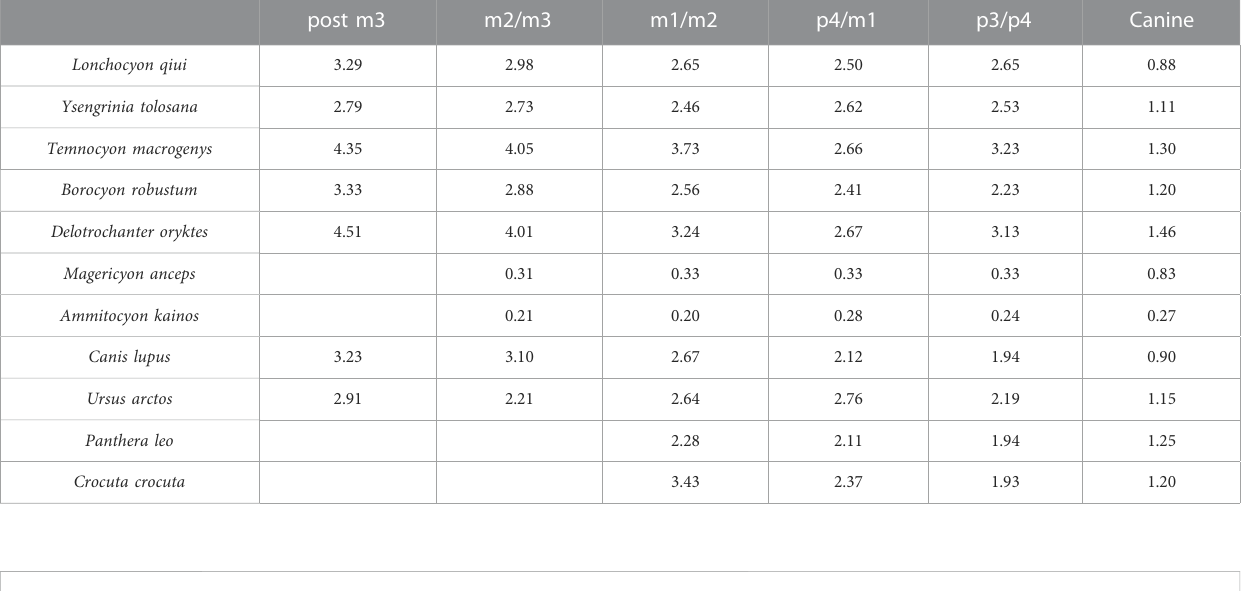
TABLE 5 Relative mandibular force (Zx/Zy) values of L. qiui and compared carnivorans along the mandible. post m3 Canine